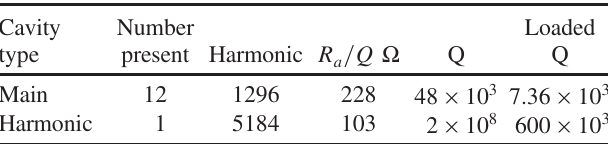
TABLE III. Cavity parameters for APS-U. R impedance using the accelerator